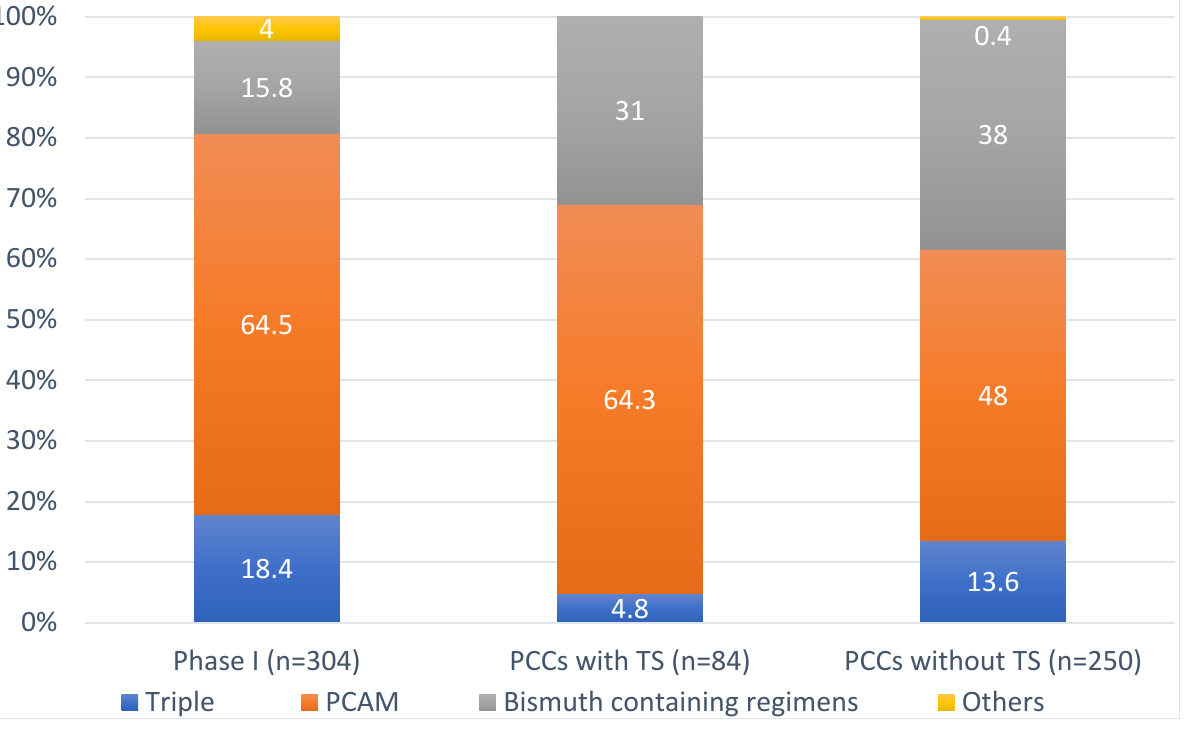
Figure 1. Antibiotic regimen prescribed. TS: training sessions, PCCs: primary care centres. Improvement of prescription appropriateness was observed in Phase II when com- pared to Phase I (Phase I vs. PCCs with TS: 75.3% [229/304] vs. 94% [79/84], p = 0.012; Phase I vs. PCCs without TS: 75.3% vs. 85.6% [214/250], p = 0.0001). Indeed, higher rates of prescription appropriateness were found comparing PCCs with TS vs. PCCs without TS in Phase II (94.0% vs. 85.6%, p = 0.04) 2.4. Eradication Rates The absence of confirmatory UBT in patients who received antibiotic treatment (which is mandatory to confirm H. pylori eradication) was a frequent finding in all groups: Phase I — 29.3% (89/304); PCCs with TS — 31.0% (26/84); PCCs without TS — 25.6% (64/250). TS did not improve the performance of eradication control UBT (69% in PCCs with TS vs. 74.4% in PCCs without TS, p = 0.33) Overall, no improvement in eradication rates was observed when comparing Phase I with Phase II PCCs with TS (79.5% [171/215] vs. 69% [40/58], p = 0.06) or between Phase I and PCCs without TS (79.5% vs. 66.1% [123/186], p = 0. 14). No differences in eradication rates were observed between groups in Phase II (69% vs. 66.1%, p = 0.68) (Figure 2). Eradication rates were influenced by prescription appropriateness. In Phase I, the eradication rate was significantly higher in patients with an adequate antibiotic treatment (85.5% [142/166] vs. 58.3% [28/48], p = 0.001). In Phase II, no differences were observed in eradication rates according to antibiotic appropriateness. In Phase II, patients with an adequate antibiotic treatment from both groups had eradication rates significantly lower compared to Phase I (85.5% vs. 67.9% [38/56], p = 0.01 in PCCs with TS; 85.5% vs. 68.1% [109/160], p = 0.002 in PCCs without TS). No differences were observed in eradication rates between PCCs with TS and without TS (67.9% vs. 68.1%, p = 0.97) (Figure 2).